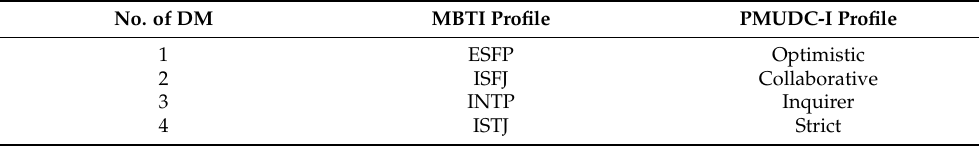
Table A2. According to [2,28], the MBTI questionnaire results were applied to four DM. No. of